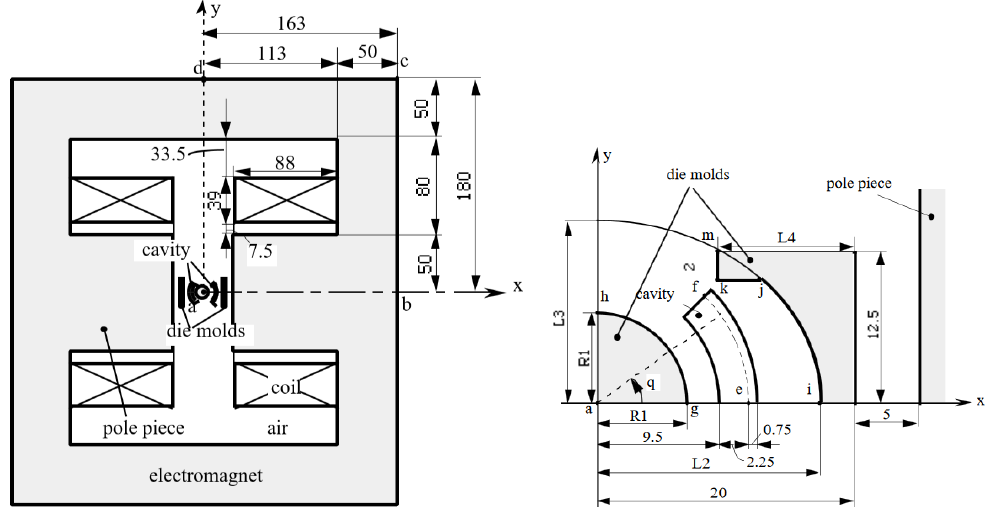
Figure 16. Model of the die press with an electromagnet: ( left ) whole view ; ( right ) enlarged view [26]. A model of the device was created. By exploiting the symmetries, only a quarter of the device was sufficient for the